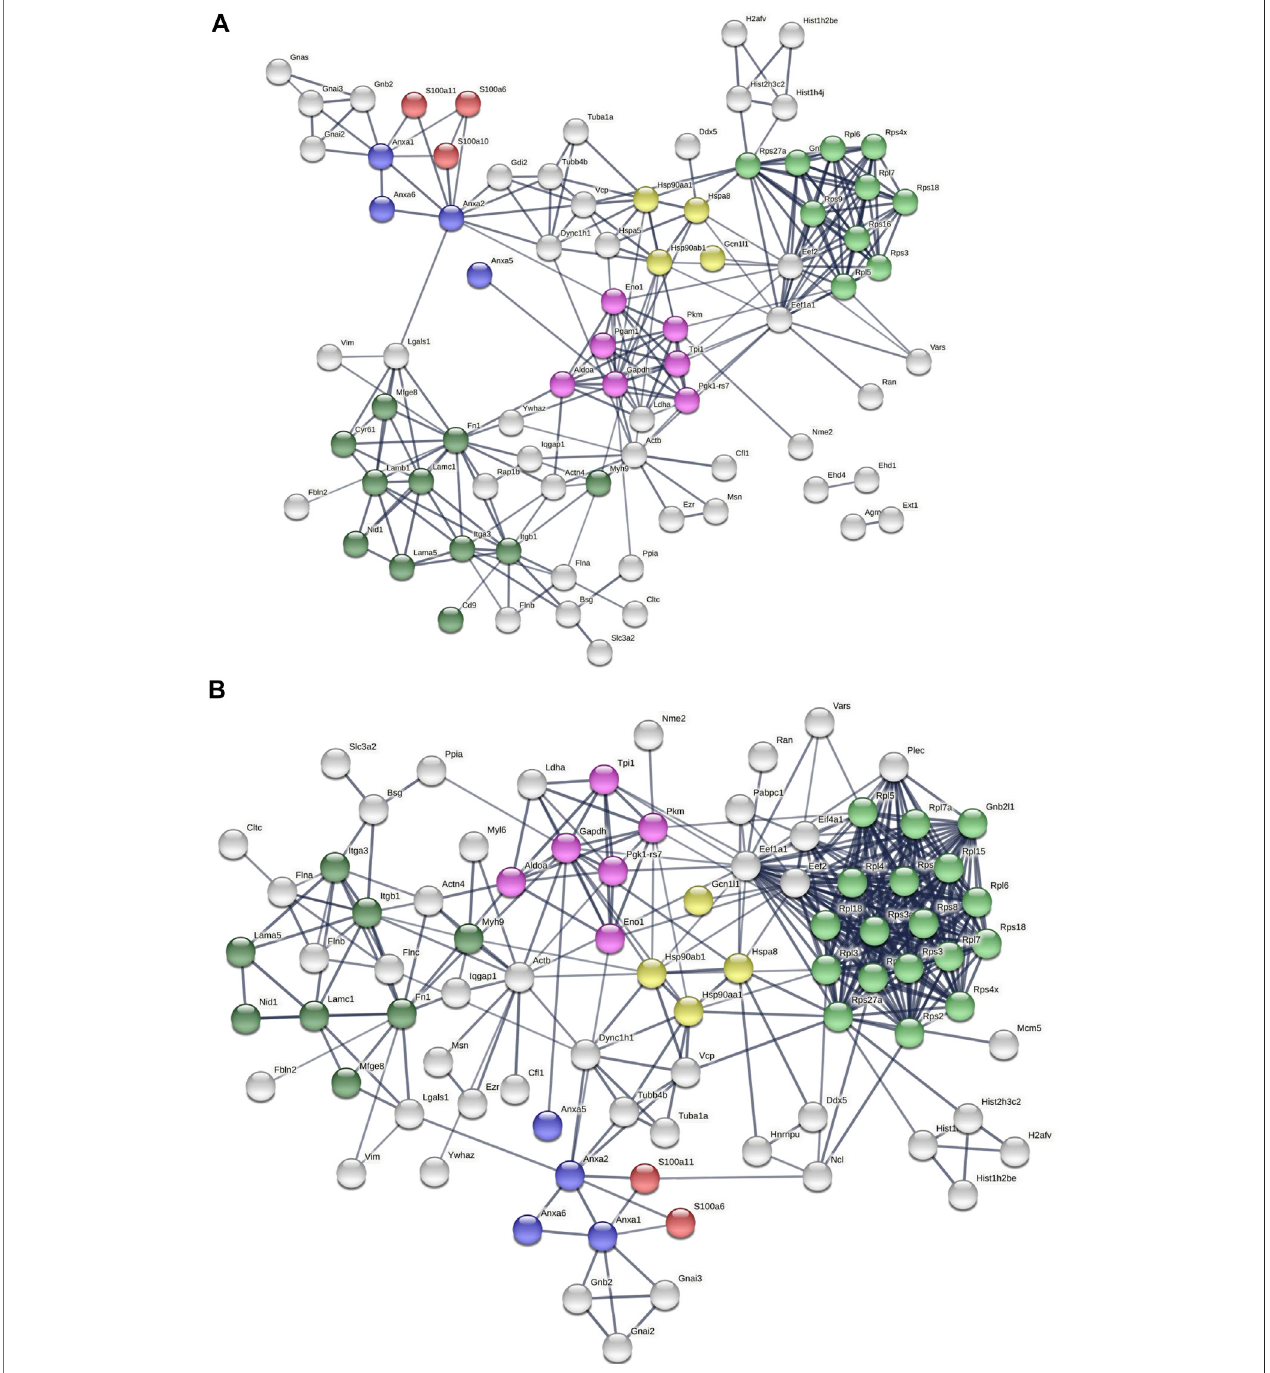
FIGURE4| Predictedprotein – protein interactions amongWTEVproteins. Protein – protein interaction analysiswasperformedbySTRING software (A) onWTVeh top100expressedproteins,and (B) onWTPAtop100expressedproteins.Theedgesindicatebothfunctionalandphysicalproteinassociations;linethicknessindicates the strength of data support; we used minimum required interaction score with high con fi dence (0.700); disconnected nodes in the network were excluded; red color depictstheS100familyproteins; bluecolorrepresentstheannexinfamily;greencolorrepresentsribosomalproteins;darkgreenrepresentscelladhesionproteins; yellow color represents stress response proteins; and pink color represents glycolysis proteins. These proteins were annotated by using UniProt and InterPro.